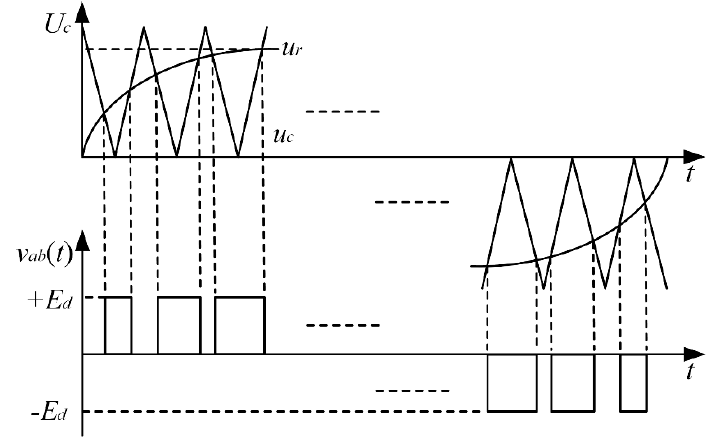
Figure 3. Schematic diagram of the third-order PWM control.